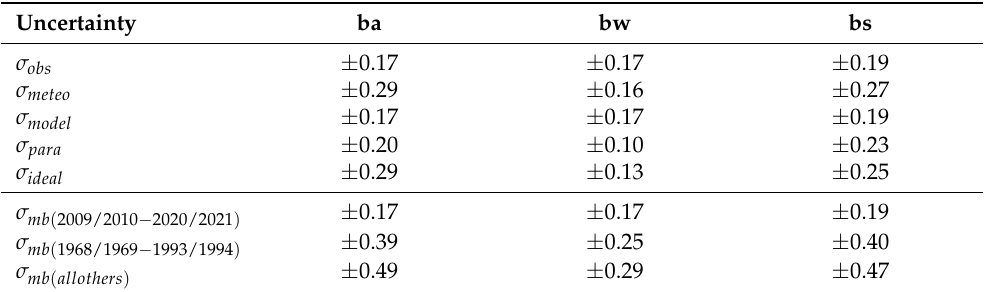
Table 2. Different uncertainties of the seasonal components considered to deduce the global uncer- tainty ( σ MB ) in mw.e.yr − 1 for the annual mean mass balance (ba), the winter balance (bw), and the summer balance